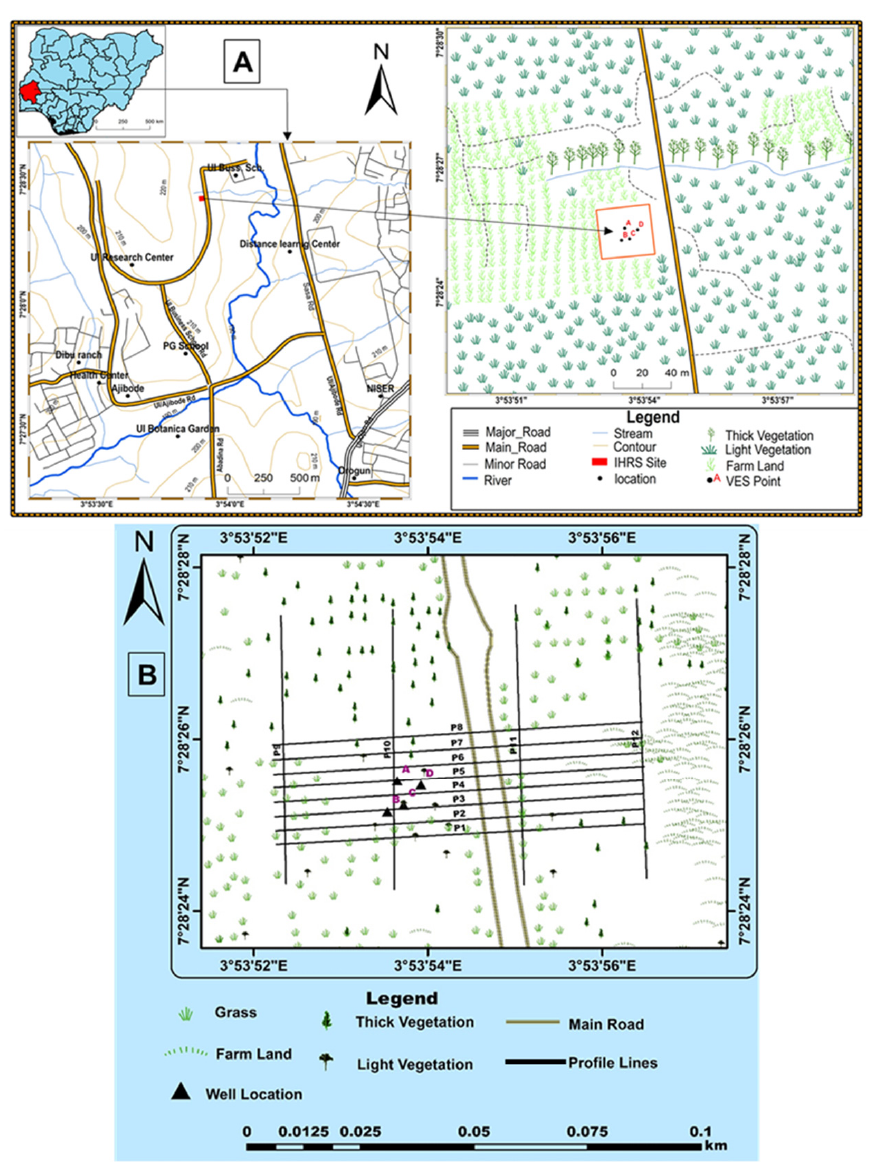
Figure 3. ( A ) Map showing the study site and the surrounding land use and ( B ) the locations of 1D electrical soundings and 2D ERT transects and boreholes.